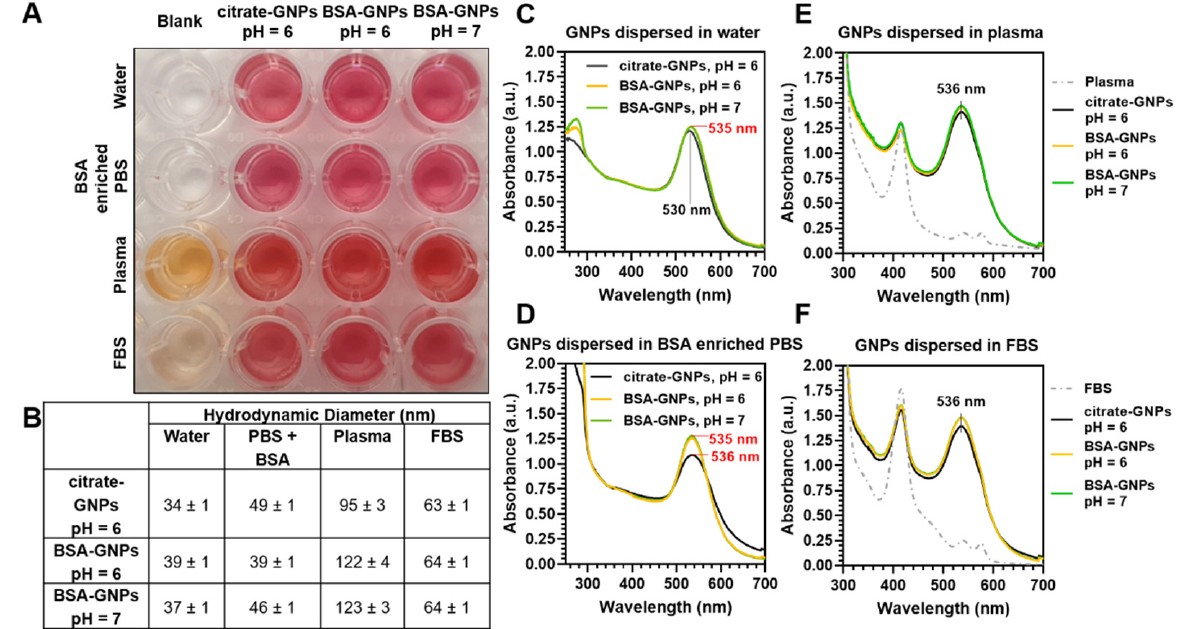
Figure 3. Optical photo, hydrodynamic diameter, and UV-Vis spectra of gold nanoparticles (GNPs) as a function of surface functionalization and immobilization media. ( A ) Photographic image showing wells containing citrate-GNPs (pH = 6) and BSA-GNPs (3 µ M, pH = 6 or pH = 7) dispersed in water, 600 µ M BSA-enriched phosphate buffered saline (PBS), plasma, and fetal bovine serum (FBS). ( B ) Dynamic light scattering (DLS) measurements show changes in hydrodynamic diameter as a function of surface functionalization and dispersion media at these pH values. ( C – F ) UV-Vis extinction spectra of citrate-GNPs and BSA-GNPs dispersed in ( C ) water, ( D ) 600 µ M BSA enriched PBS, ( E ) plasma, and ( F ) FBS.